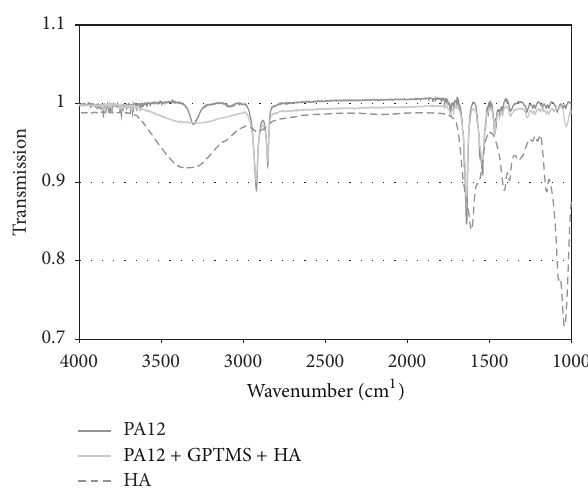
Figure 3: FTIR-ATR spectra of PA12 prior to and after chemical attachment of the HA base layer via GPTMS in comparison to HA.